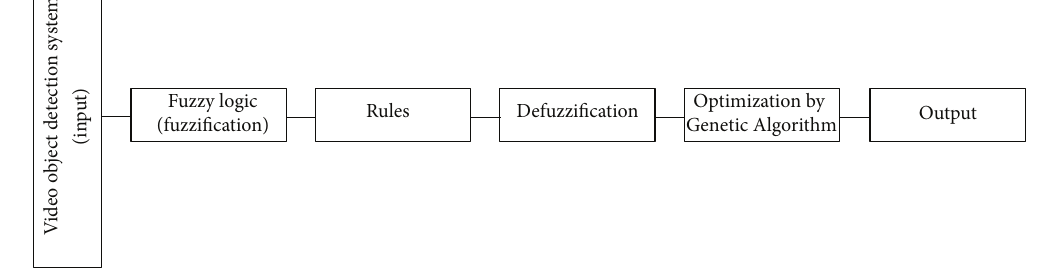
Figure 1: Flowchart of the